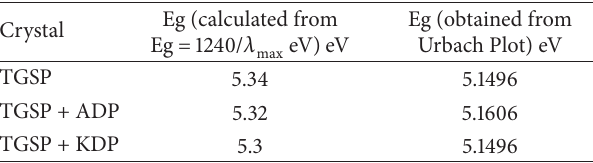
Table 1: Energy band gap values of grown